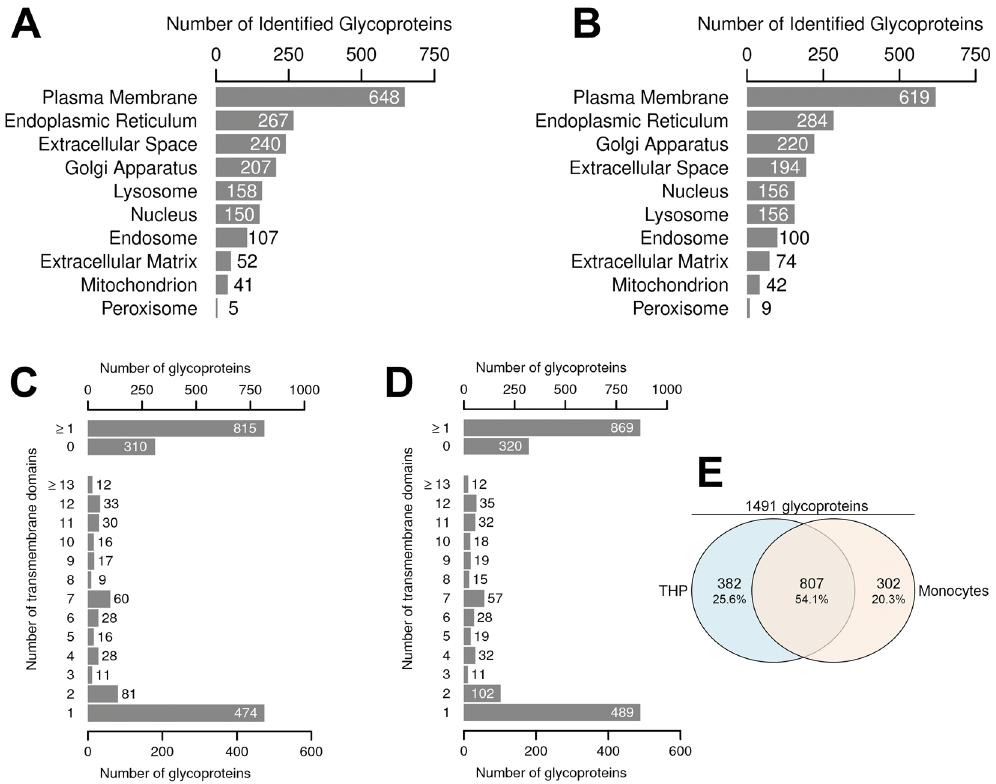
Figure 2. Glycoprotein identification in CD14 + monocytes and THP-1 cells by LC-MS/MS. ( A,B ) Gene ontology-based cellular component analysis of all glycoproteins identified in CD14 + monocytes ( A , unique glycoproteins + soluble isoforms) and THP-1 cells ( B , unique glycoproteins). Numbers of glycoproteins in manually selected cellular components are given. ( C,D ) Distribution of glycoproteins identified in CD14 + monocytes ( C ) and THP-1 cells ( D ) with predicted transmembrane helices identified in the two data sets. Upper part: glycoproteins with ≥ 1 or 0 predicted transmembrane helices, lower part: distribution of glycoproteins according to the number of predicted transmembrane domains. ( E ) Overlap between the 1491 annotated unique glycoproteins identified in THP-1 cells (1189) and CD14 + monocytes